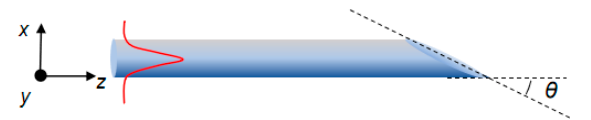
Figure 1. Schematic diagram of simulated subwavelength-diameter ( SD ) optical fibers with an oblique endface.